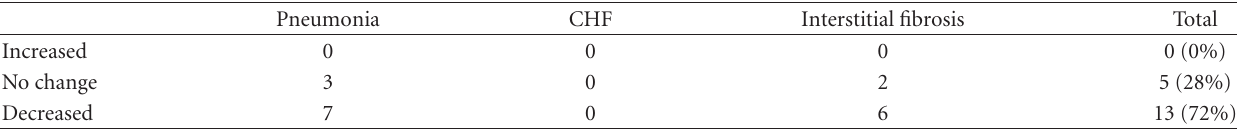
Table 2: Number of patients whose crackle pitch increased, decreased, and did not change during expiration. CHF